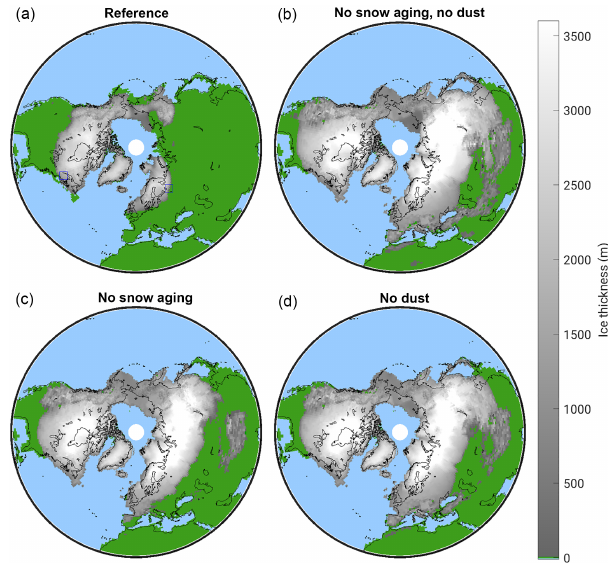
Figure 8. Ice sheet extent at the Last Glacial Maximum (21ka) for (a) the reference simulation, (b) the simulation without snow aging and dust effect on snow albedo, (c) the simulation without snow aging, and (d) the simulation without dust on snow.